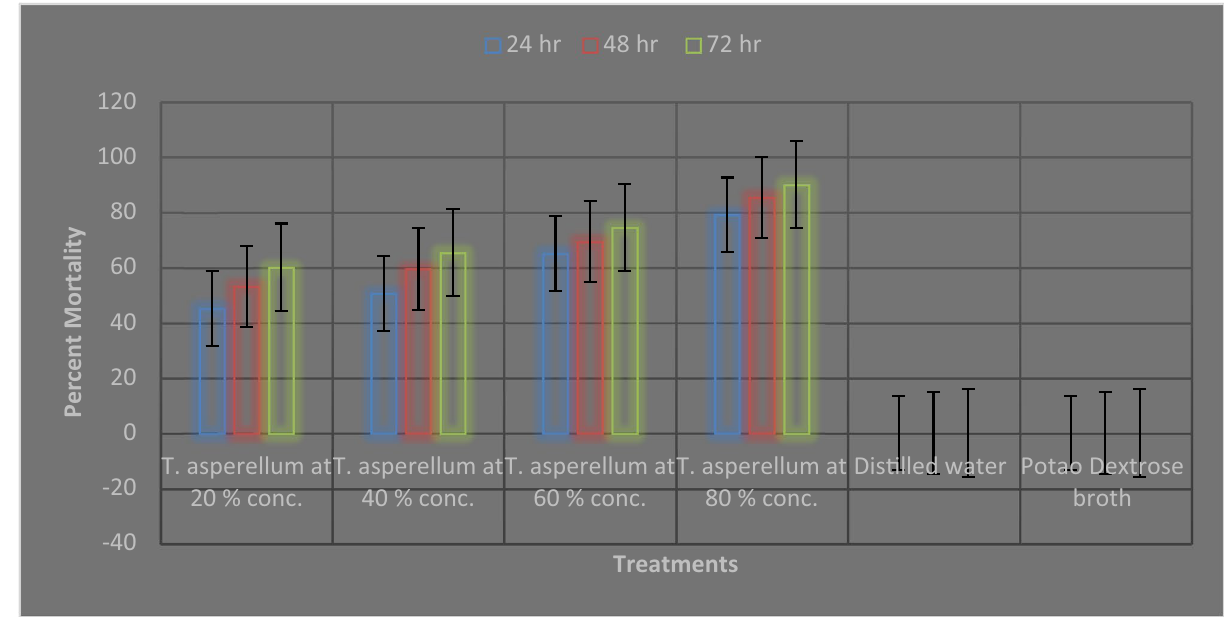
Figure 4. Effect of T. asperellum FbMi6 on juveniles (J 2 ) mortality of M. incognita under in-vitro conditions.